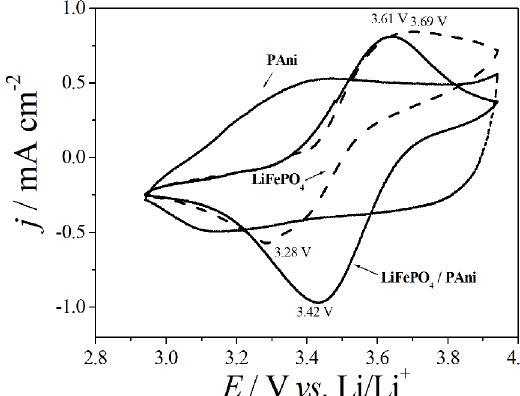
Figure 8. Cyclic voltammograms recorded at 0.1 mV s -1 , in a 1.0 mol L -1 LiClO in EC:DMC 1:1 ( V / V ), of LiFePO synthesized at 4 4 200 °C for 10 h, of PAni and LiFePO 4